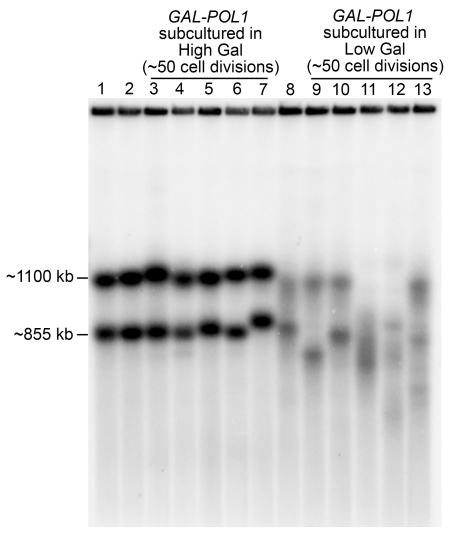
CHEF gel analysis of the size of rDNA arrays in cells with high and low levels of polymerase alpha.Individual colonies of a GAL-POL1 strain were sub-cultured twice (about 50 cell divisions) in media with high or low levels of galactose. We subsequently isolated DNA from these derivatives in agarose plugs, treated the plugs with BamHI (which does not cleave in the rDNA), and separated the resulting fragments by CHEF gel electrophoresis. The separated DNA molecules were transferred to membranes and hybridized to an rDNA-specific probe. The derivatives in each lane were: 1 (GAL-POL1 strain before sub-culturing), 2 (GAL-POL1 derivative sub-cultured once on high galactose), 3–7 (five individual derivatives sub-cultured twice on high galactose), 8 (GAL-POL1 strain sub-cultured once on low galactose), 9–13 (five individual isolates sub-cultured twice on low galactose).